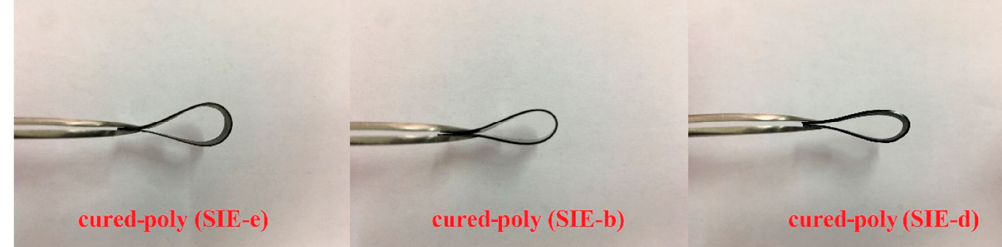
Figure 9. Thin film photographs for cured-poly (SIE-e), cured-poly (SIE-b), and cured-poly (SIE-d).